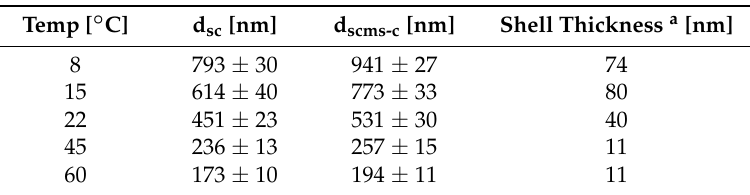
Table 1. Sizes of the SCMS particles and estimated shell thickness for various temperatures of their synthesis as determined from SEM images.